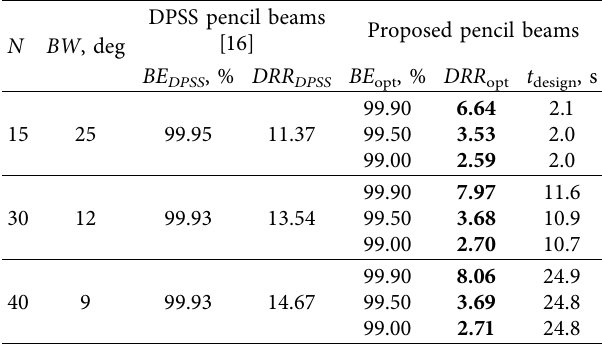
Table 11: Beam efciency and dynamic range ratio of DPSS pencil beam arrays [16] and proposed arrays with minimum DRR and BE des of 99.9%, 99.5%, and 99.0%, together with design time of proposed arrays, t design . Improvements are highlighted in